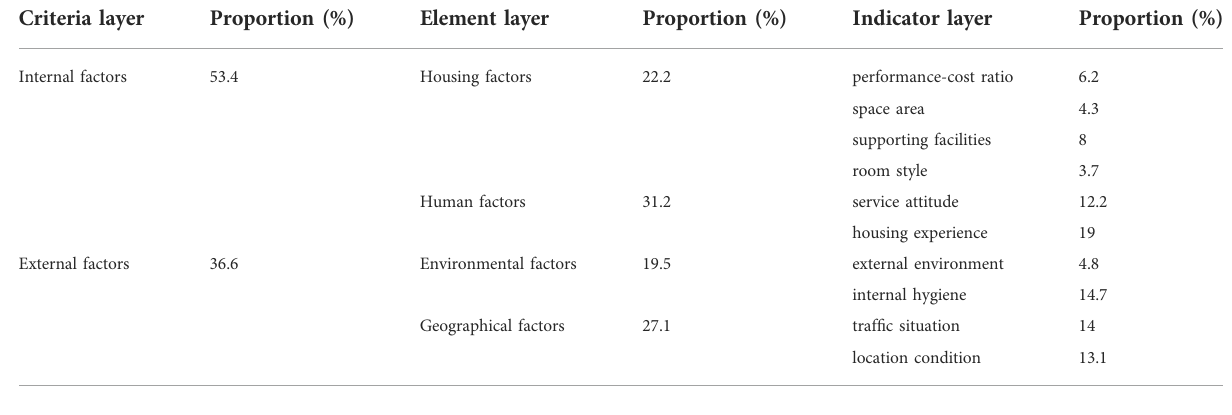
TABLE 6 Percentage of reviews.